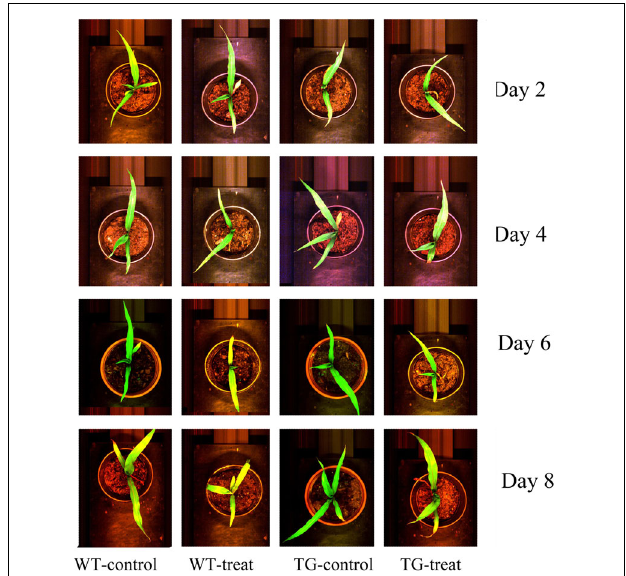
FIGURE 2 | Phenotype of wild-type (WT) and transgenic (TG) maize sprayed with glyphosate after 2, 4, 6, and 8 days, compared with the corresponding control ones (in their original RGB color